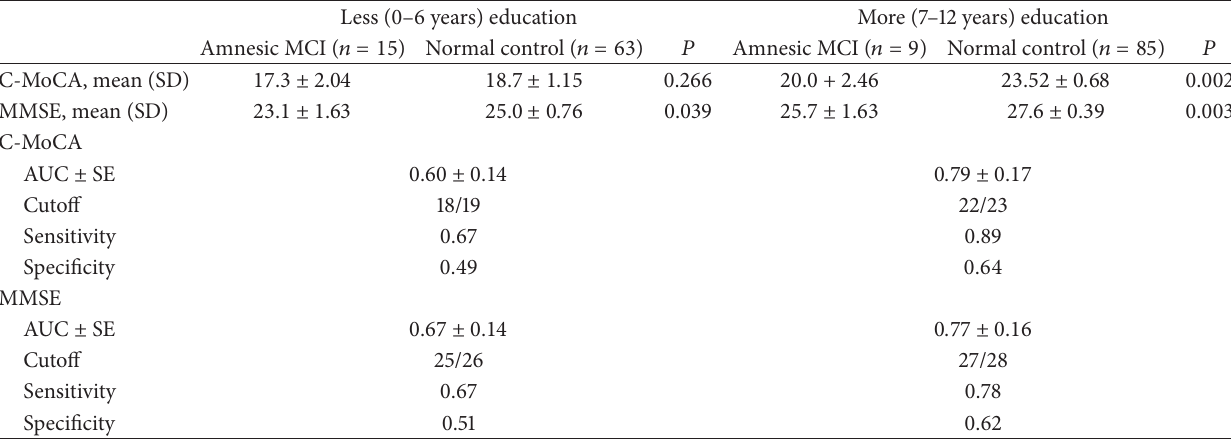
Table 4: C-MoCA and MMSE of aMCI and normal controls and test performance by educational groups.